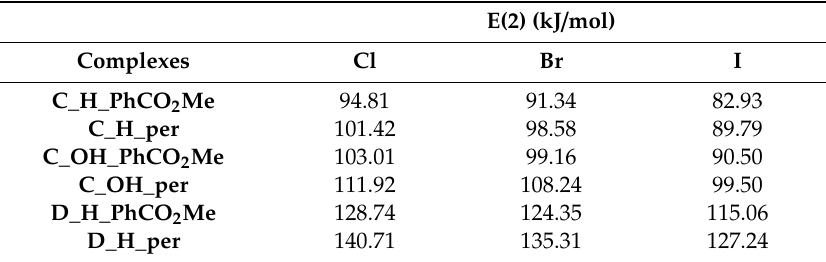
Table 7. NBO values of charge transfer energy E(2), in kJ / mol, from lone pairs of halide to σ *(X-C) antibonding orbital.